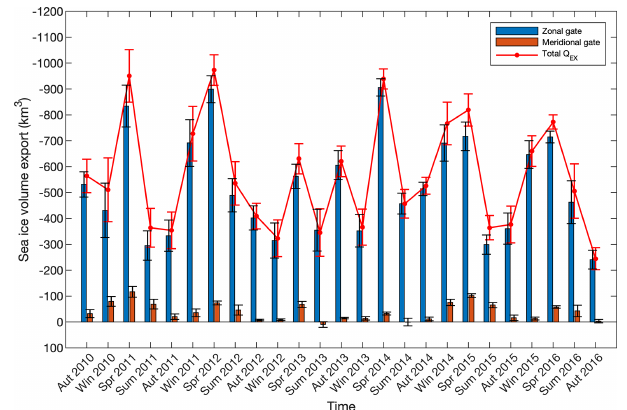
Figure 10. CMST seasonal Arctic sea ice volume export (unit: km 3 ) through the Fram Strait with corresponding uncertainty. Q EX repre- sents the sea ice volume export based on CMST thickness and drift (in the following maps as